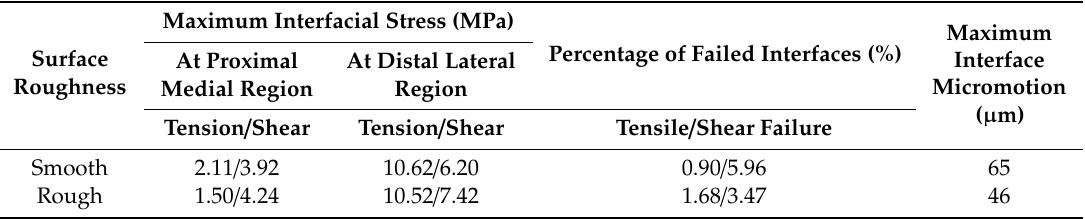
Table 2. Maximum stress induced within cemented femoral components under gait phase of